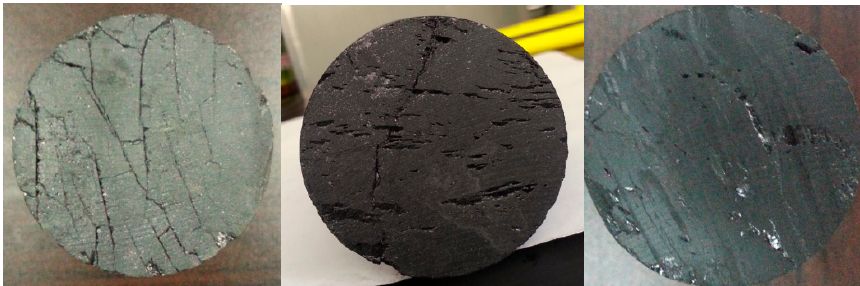
Figure 4. Photos of sectional fissure distribution of typical specimen before failure test. From left to right: specimen from outburst risk seam, weak bursting liability seam, strong bursting liability.